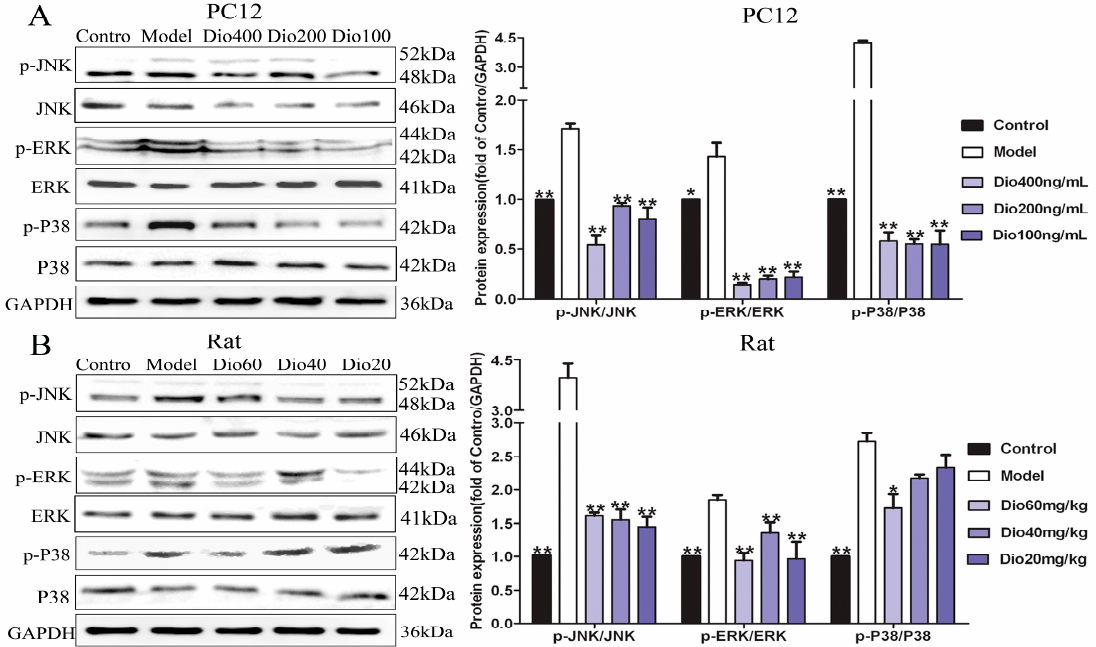
Figure 8. Dioscin adjusted MAPKs signal pathway. ( A ) Effects of dioscin on the levels of phosphorylated MAPKs in PC12 cells treated by H 2 O 2 . ( B ) Effects of dioscin on the levels of phosphorylated MAPKs in brain tissue of aging rats. Data are presented as the mean ±SD (n = 3). * p < 0.05 and ** p < 0.01 compared with model groups.